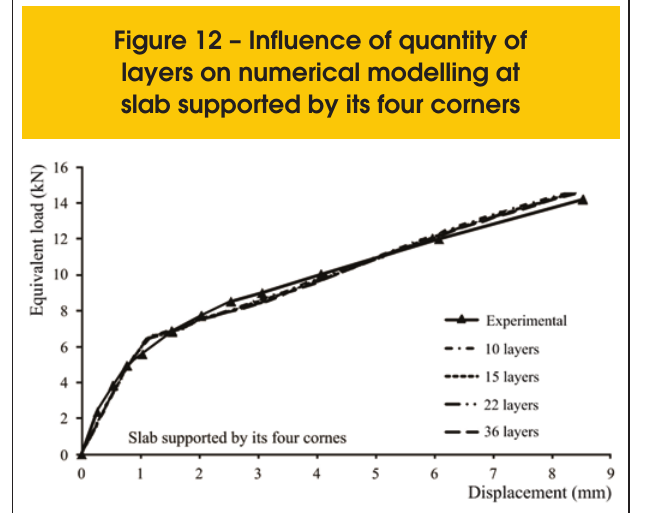
Figure 13 – Comparison between proposed model and FEM models to